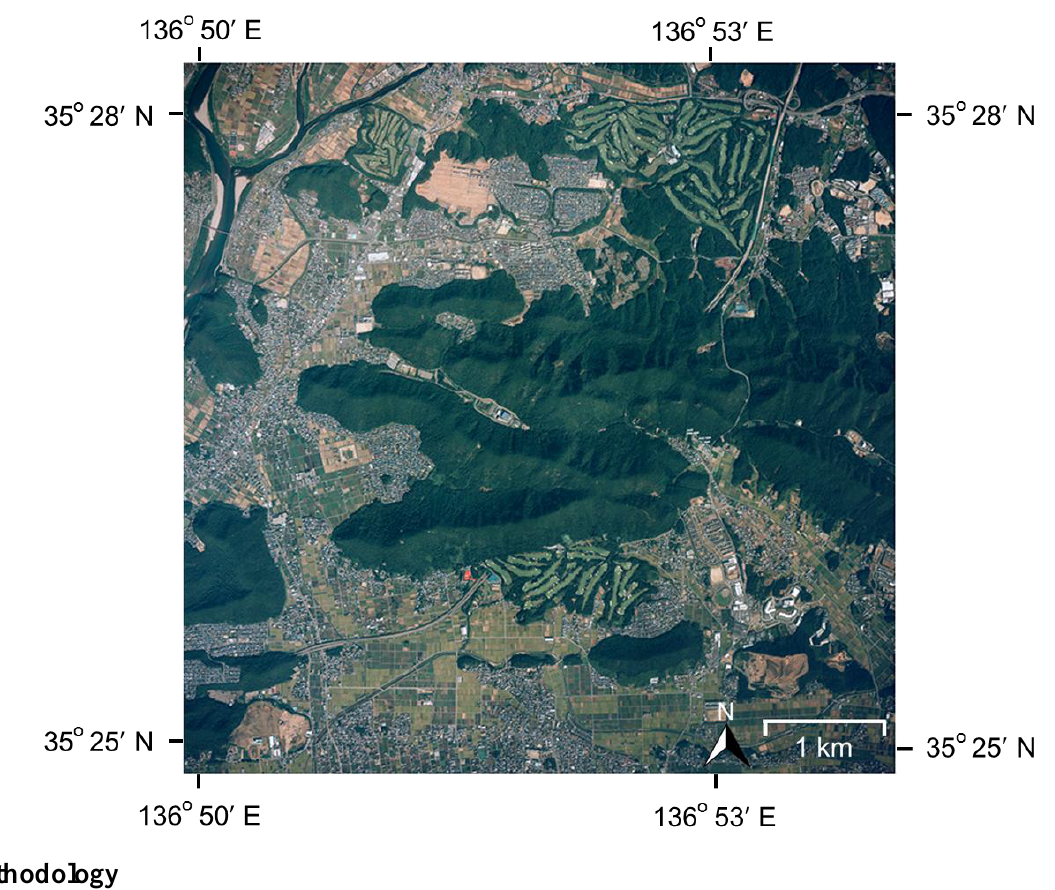
Figure 2. Aerial photography used in this